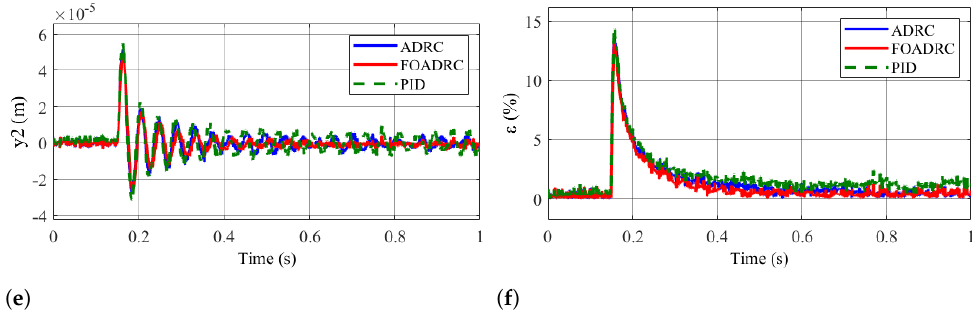
Figure 10. Transient response of rotor (taking into account measurement noise) when a hydrodynam- ics force is applied in the axial and radial directions with FOADRC, ADRC, and PID controllers ( a – e ). The eccentricity ratio is presented in ( f ). Table 3. The control performance benchmark.